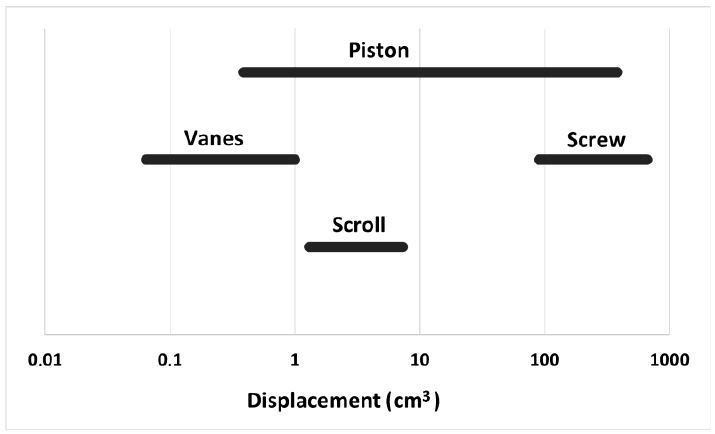
Figure 21. Distribution of the displacement values for the analyzed expanders.